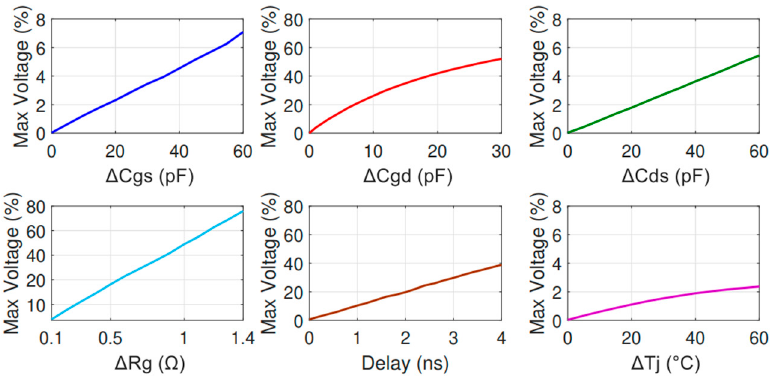
Figure 12. Sensitive analysis results.